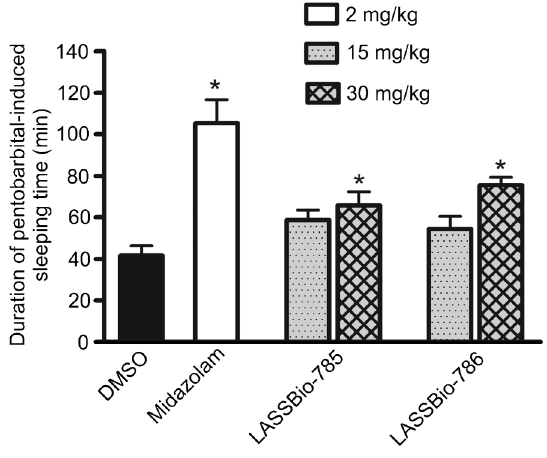
Figure 2. Effects of midazolam (2 mg/kg, ip ), LASSBio-785 (15 and 30 mg/kg, ip ) and LASSBio-786 (15 and 30 mg/kg, ip ) on the duration of sodium pentobarbital-induced sleeping time. Data are reported as means ± SE (n = 10). *P , 0.05 compared to DMSO (Dunnett multiple comparison test).